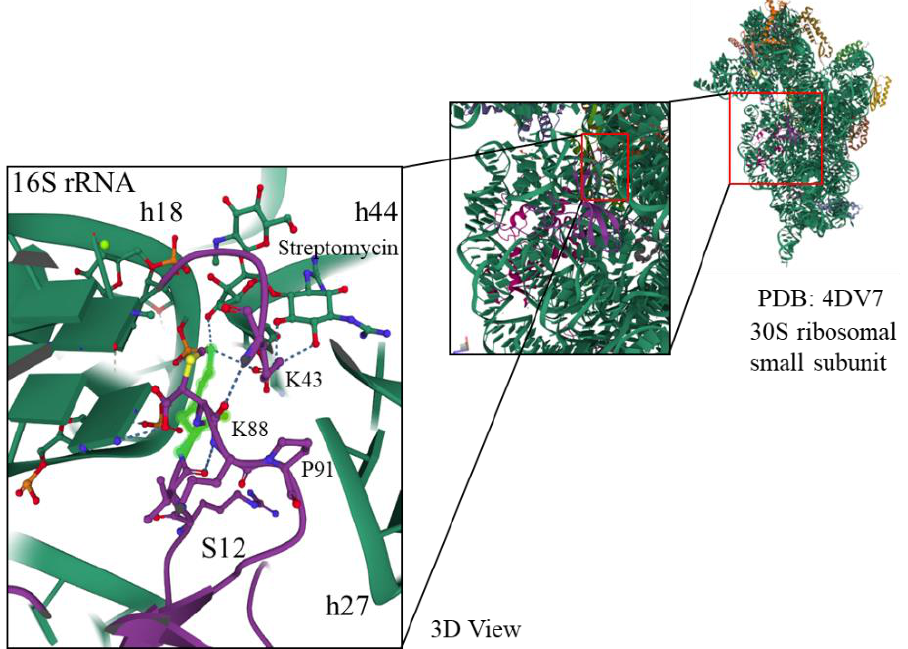
Figure 5. Three-dimensional (3D) view of the decoding center area, including ribosomal proteins S12 and S4 and the three 16S rRNA helices h18, h27, and h44 from the 30S small ribosomal subunit topology of T. thermophilus HB8 with streptomycin from the Protein Data Bank (RCSB PDB, www.pdb.org; accession number 4DV7; original contributors: Demirci H, Murphy IVF, Murphy E, Gregory ST, Dahlberg AE, and Jogl G.) [29]. From the deposited structure data, the decoding region was “zoomed-in” using Mol* Viewer [28], and the streptomycin-interacting amino acid residues of ribosomal proteins (violet color) and nucleotides of 16S rRNA helices (green color) were marked.